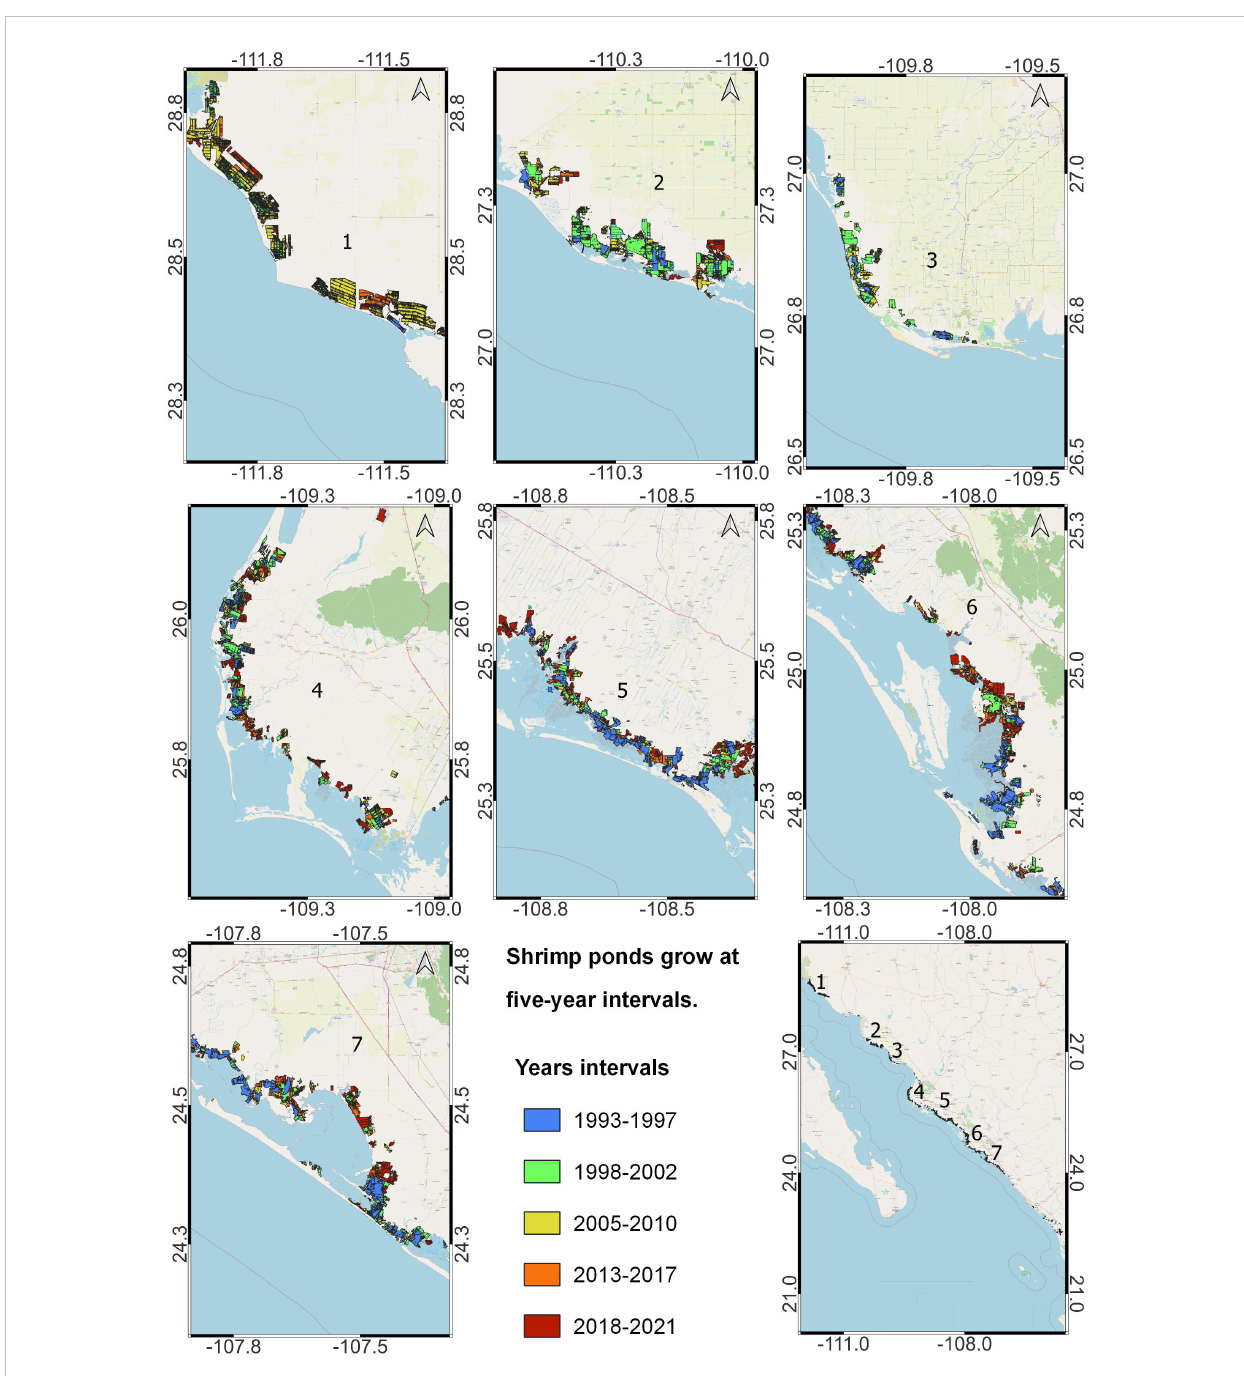
FIGURE 2 Shrimp ponds detected from 1993 to 2021 using remote sensing. Owing to the extended area occupied and for an improved observation of growth, the data were grouped by fi ve-year